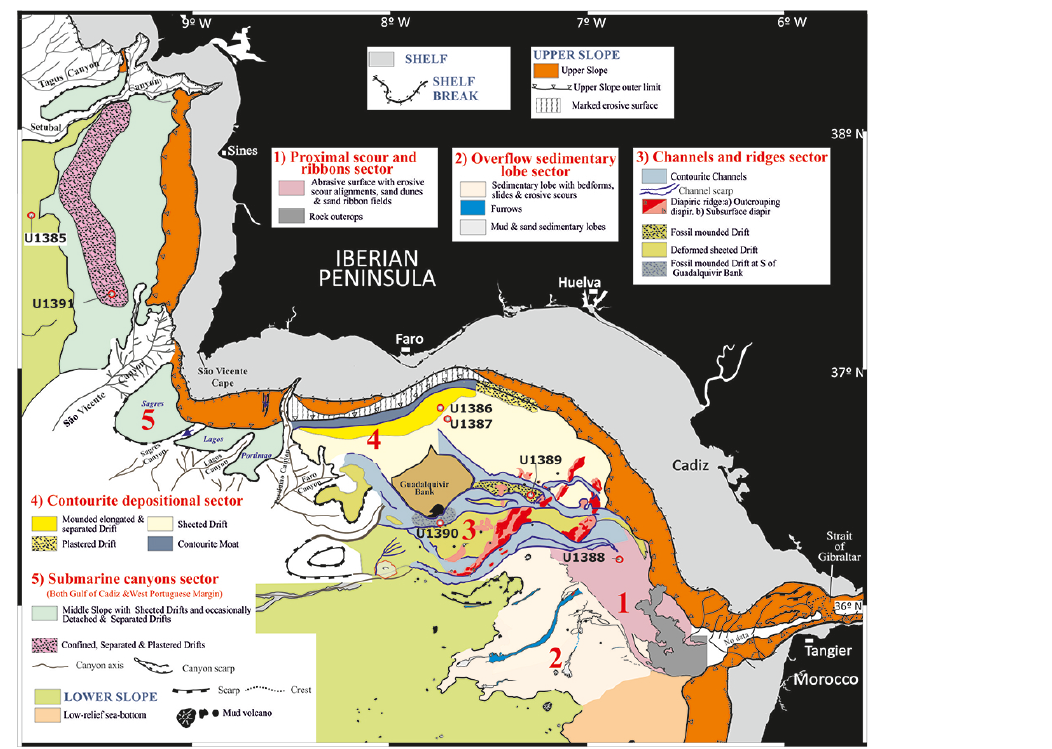
Figure 2. Regional map of the contourite depositional system on the middle slope of the Gulf of Cádiz and west Iberian margin with Expedition 339 site locations. Morphosedimentary sectors (1–5) based on Hernández-Molina et al. (2003, 2006) and S. Lebreiro (personel communication,